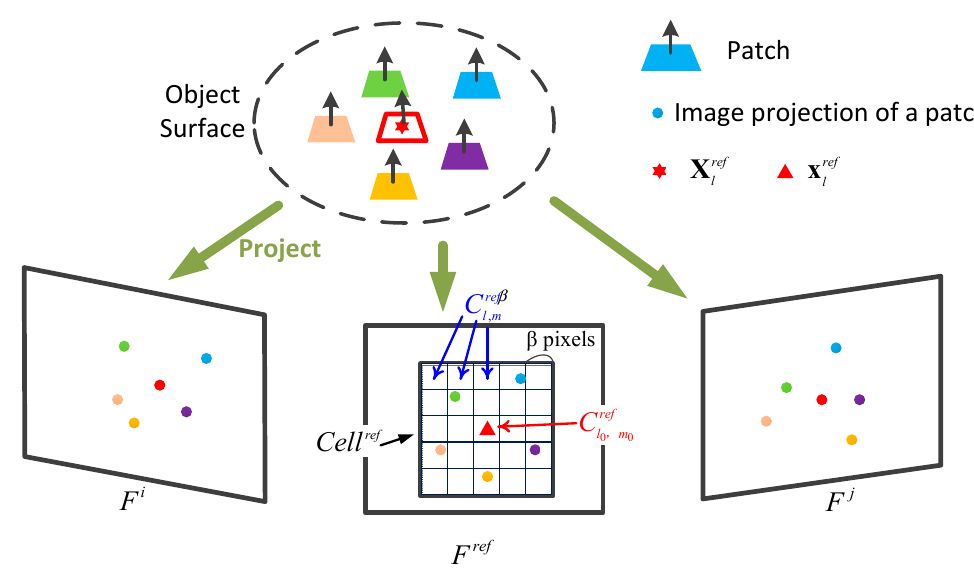
Figure 3. Schematic of the reconstruction, including explanation of parameters and image projections of reconstructed patches in their visible images.